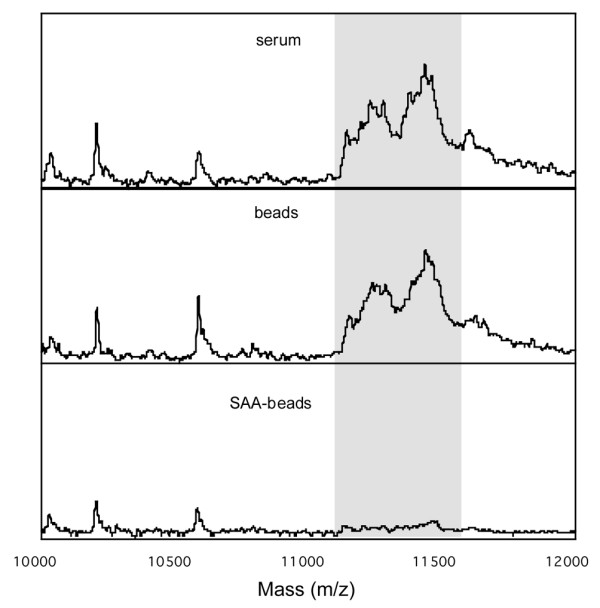
Immunoprecipitation of SAA in SJIA, resulting in loss of the 11.4- to 11.6-kDA peak cluster. A pooled sample from four sera before conventional treatment (top panel) was incubated with either Protein A–Sepharose beads alone (middle panel) or Protein A–Sepharose beads bound with anti-SAA antibody (lower panel). After immunoprecipitation, the depleted serum was subjected to SELDI-TOF MS. The 11.4-to 11.6-kDa m/z peak cluster is shown in grey. MRA, humanized anti-IL-6 receptor monoclonal antibody; SAA, serum amyloid A; SELDI-TOF MS, surface-enhanced laser desorption/ionization time-of-flight mass spectrometry; SJIA, systemic-onset juvenile idiopathic arthritis.